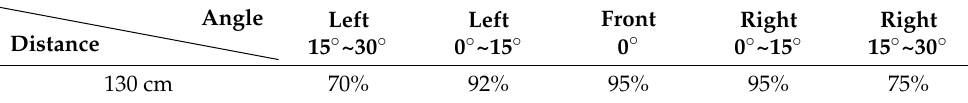
Table 5. The success rates of floating garbage collection for the water surface cleaning task.